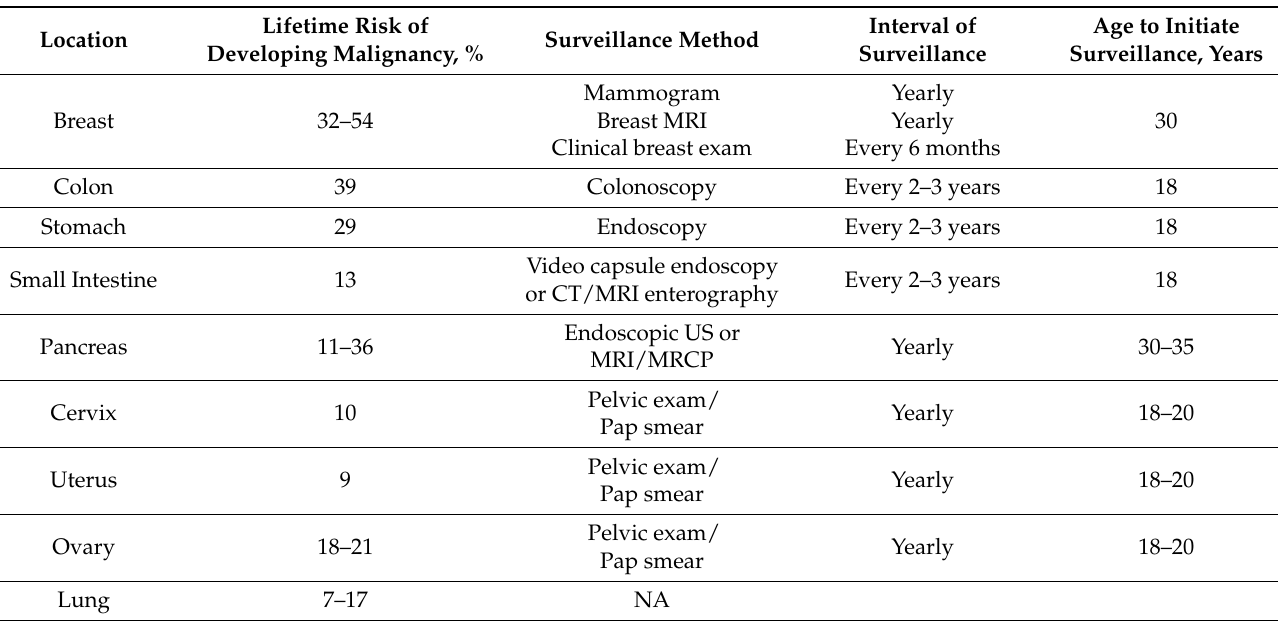
Table 2. NCCN adult surveillance guidelines.